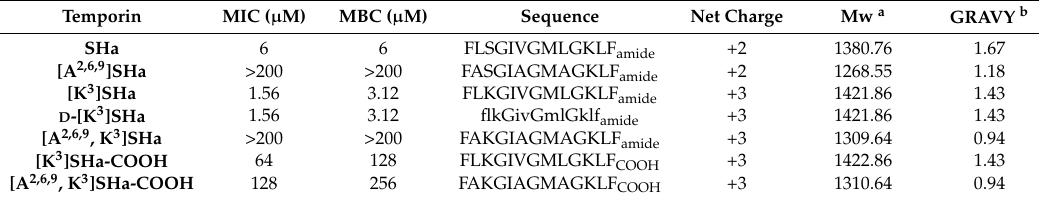
Table 1. Anti- Listeria activity of temporin analogs in solution and different peptides characteristics. MIC: minimal inhibitory concentration. MBC: minimal bactericidal concentration. Lowercase letters indicate D -amino acid residues.